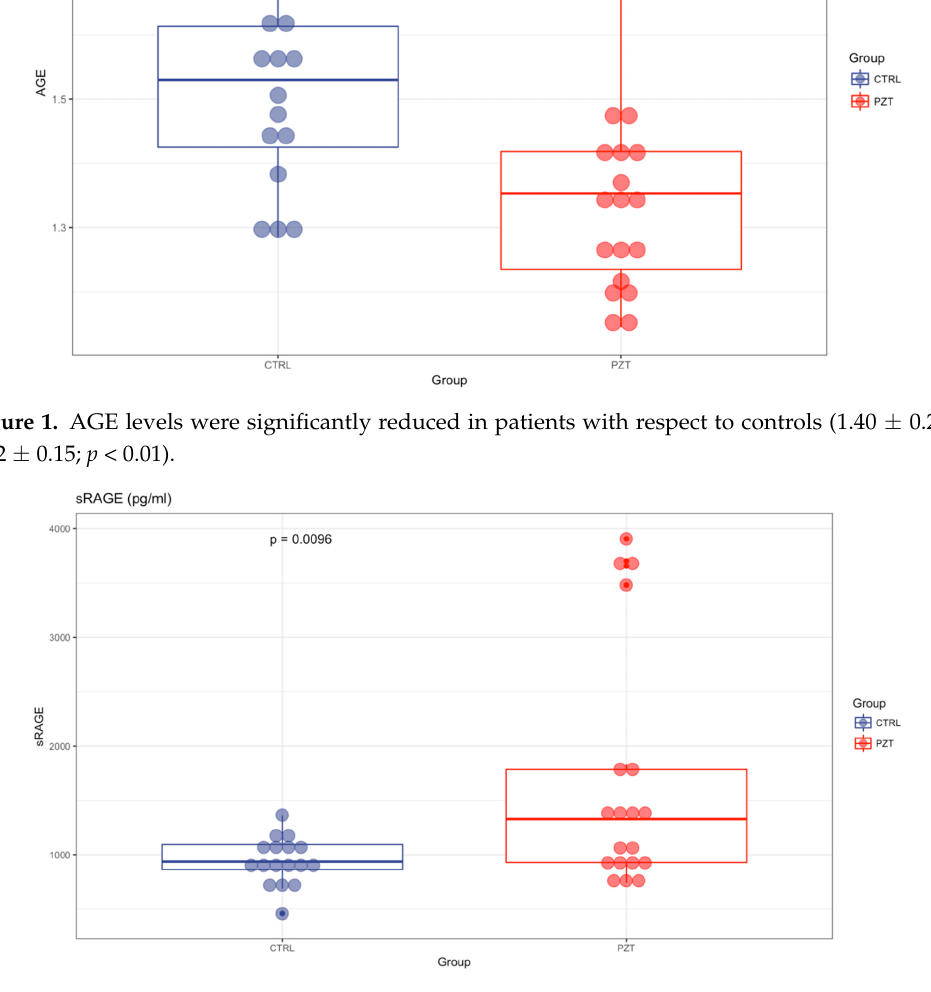
Figure 2. sRAGE was significantly elevated in patients affected by multiple myeloma (MM) compared to healthy subjects (1686.3 pg/mL ± 1107 vs 940.67 pg/mL ± 218; p < 0.01).